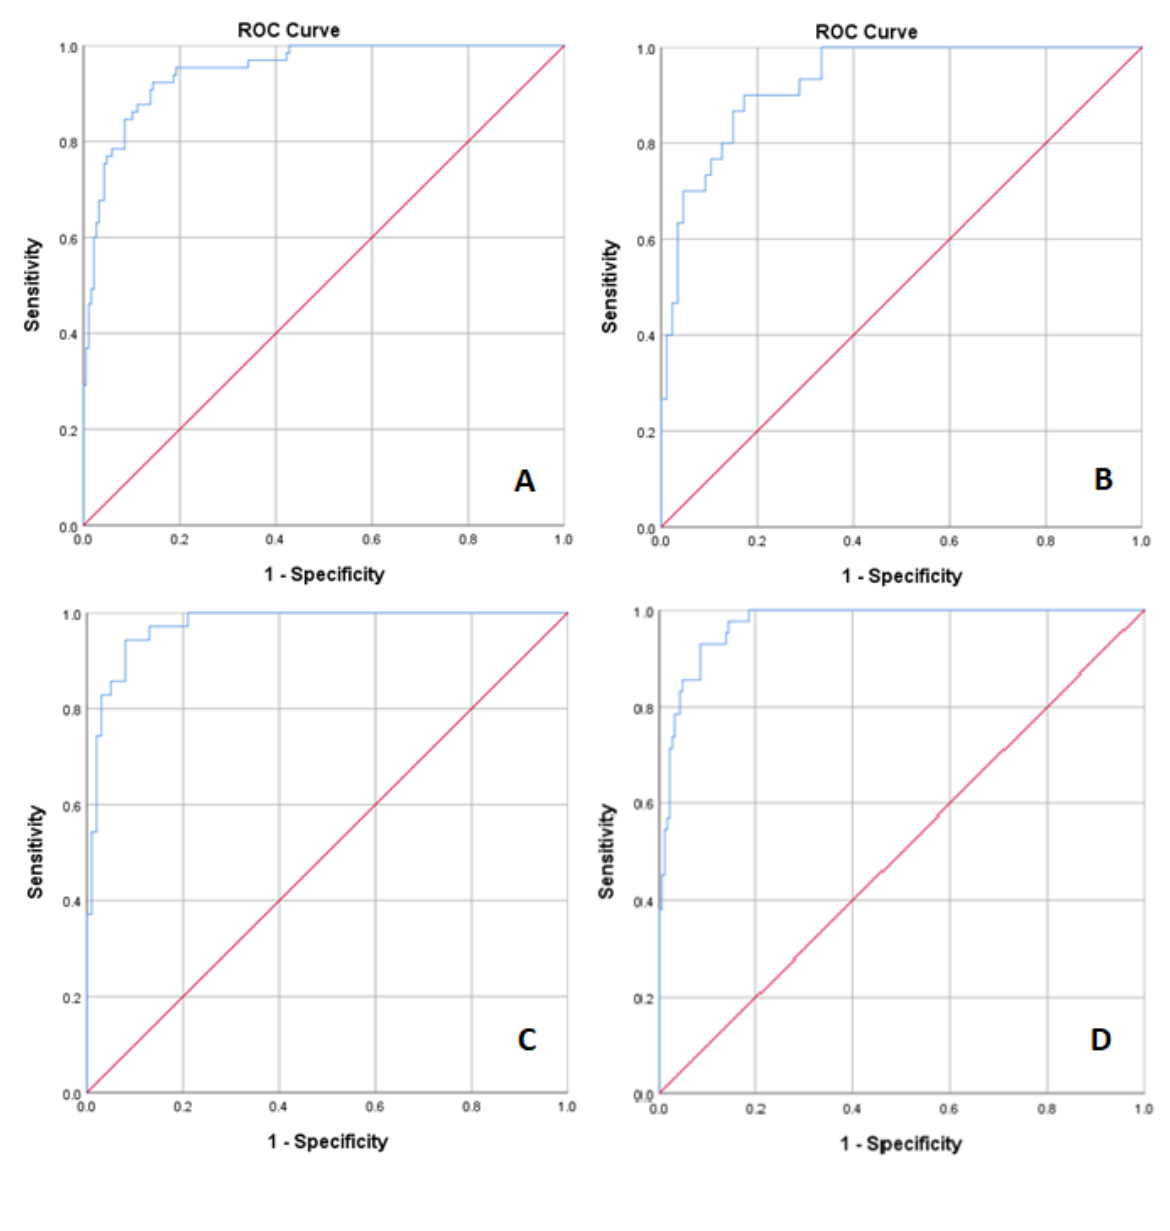
Figure 2. Receiver operating characteristic curve and AUC for (A) COPD total cohort (group 1), AUC=0.95 (95% CI 0.92-0.98); (B) COPD with infectious comorbidity (group 2A), AUC=0.93 (95% CI 0.88-0.98); (C) COPD without infectious comorbidity (group 2B), AUC=0.974 (95% CI 0.95-1.00); (D) COPD diagnosed by spirometry group (group 3), AUC=0.973 (95% CI 0.95-1.00). AUC: area under the curve; COPD: chronic obstructive pulmonary